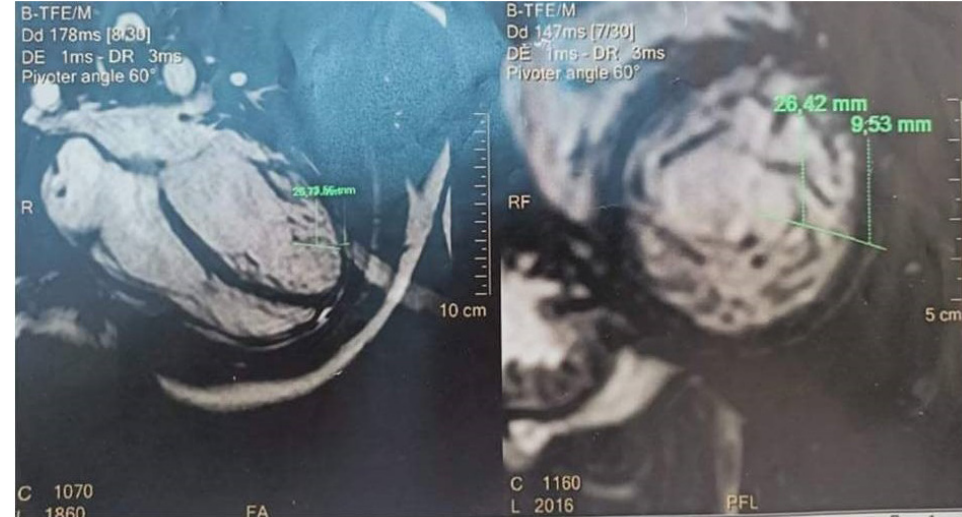
Figure 2. Cardiac magnetic resonance imaging showing non compacted trabeculation.